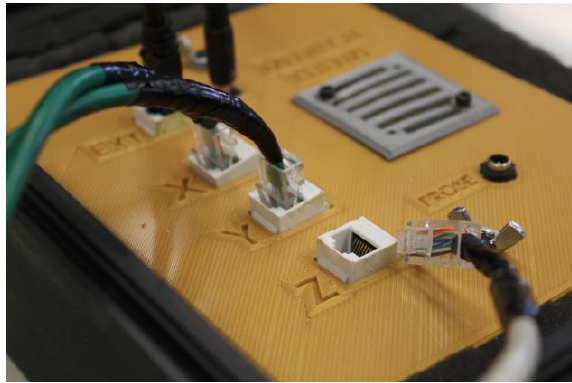
Figure 8. Sensors, Motors, Heaters and Fans all clipped into the Control box via Ethernet cables.